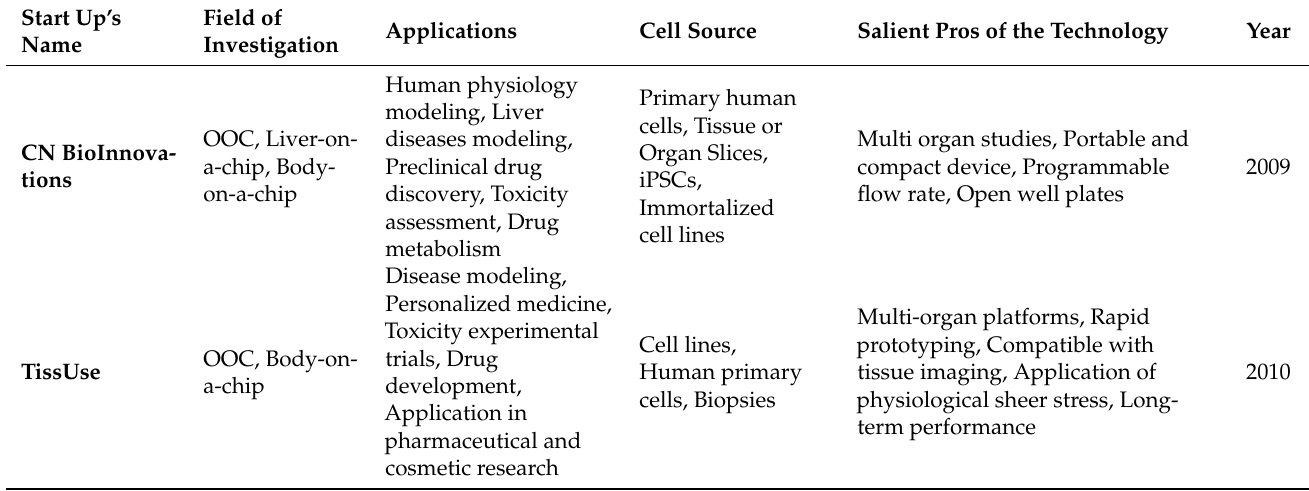
Table 8. List of the most important start-up leaders in the OOC field and highlights of each technology (Adapted from Azizipour et al. [328] with slight